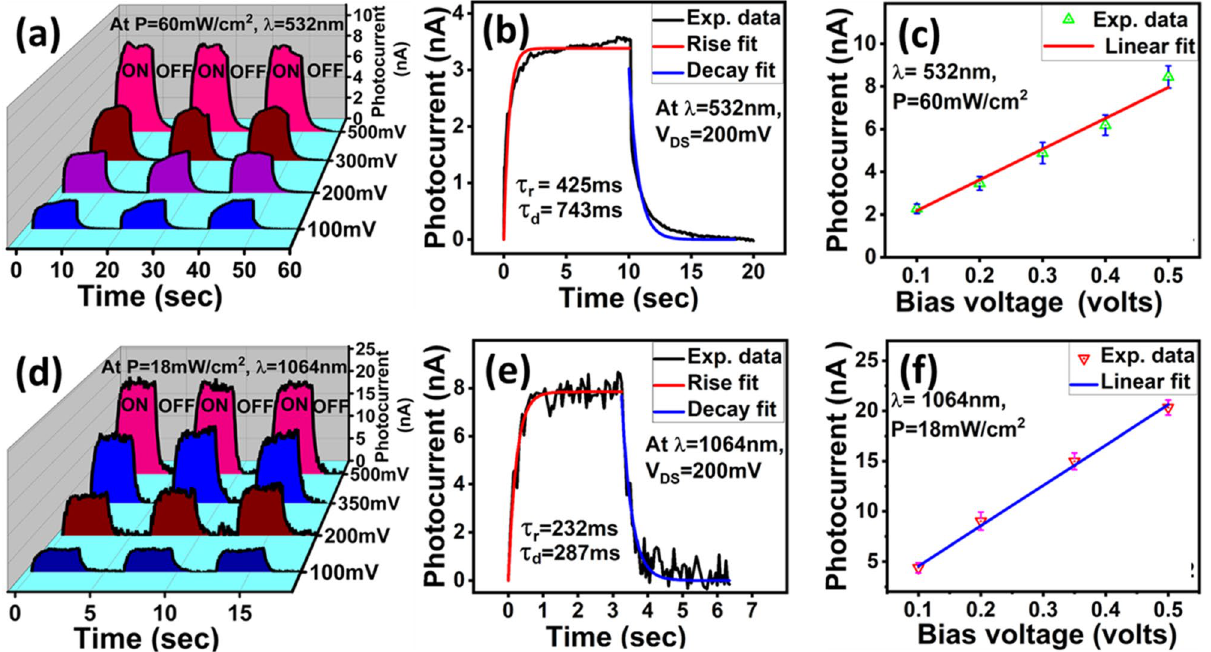
Figure 2. Time dependent photocurrent measurements. ( a , d ) photoresponse of WTe 2 films under 532 and 1064 nm laser irradiations respectively. ( b , e ) Red and blue curves represent rise and decay fit constants. ( c , f ) Bias dependent photocurrent measurements under the illumination of laser lights 532 and 1064 nm